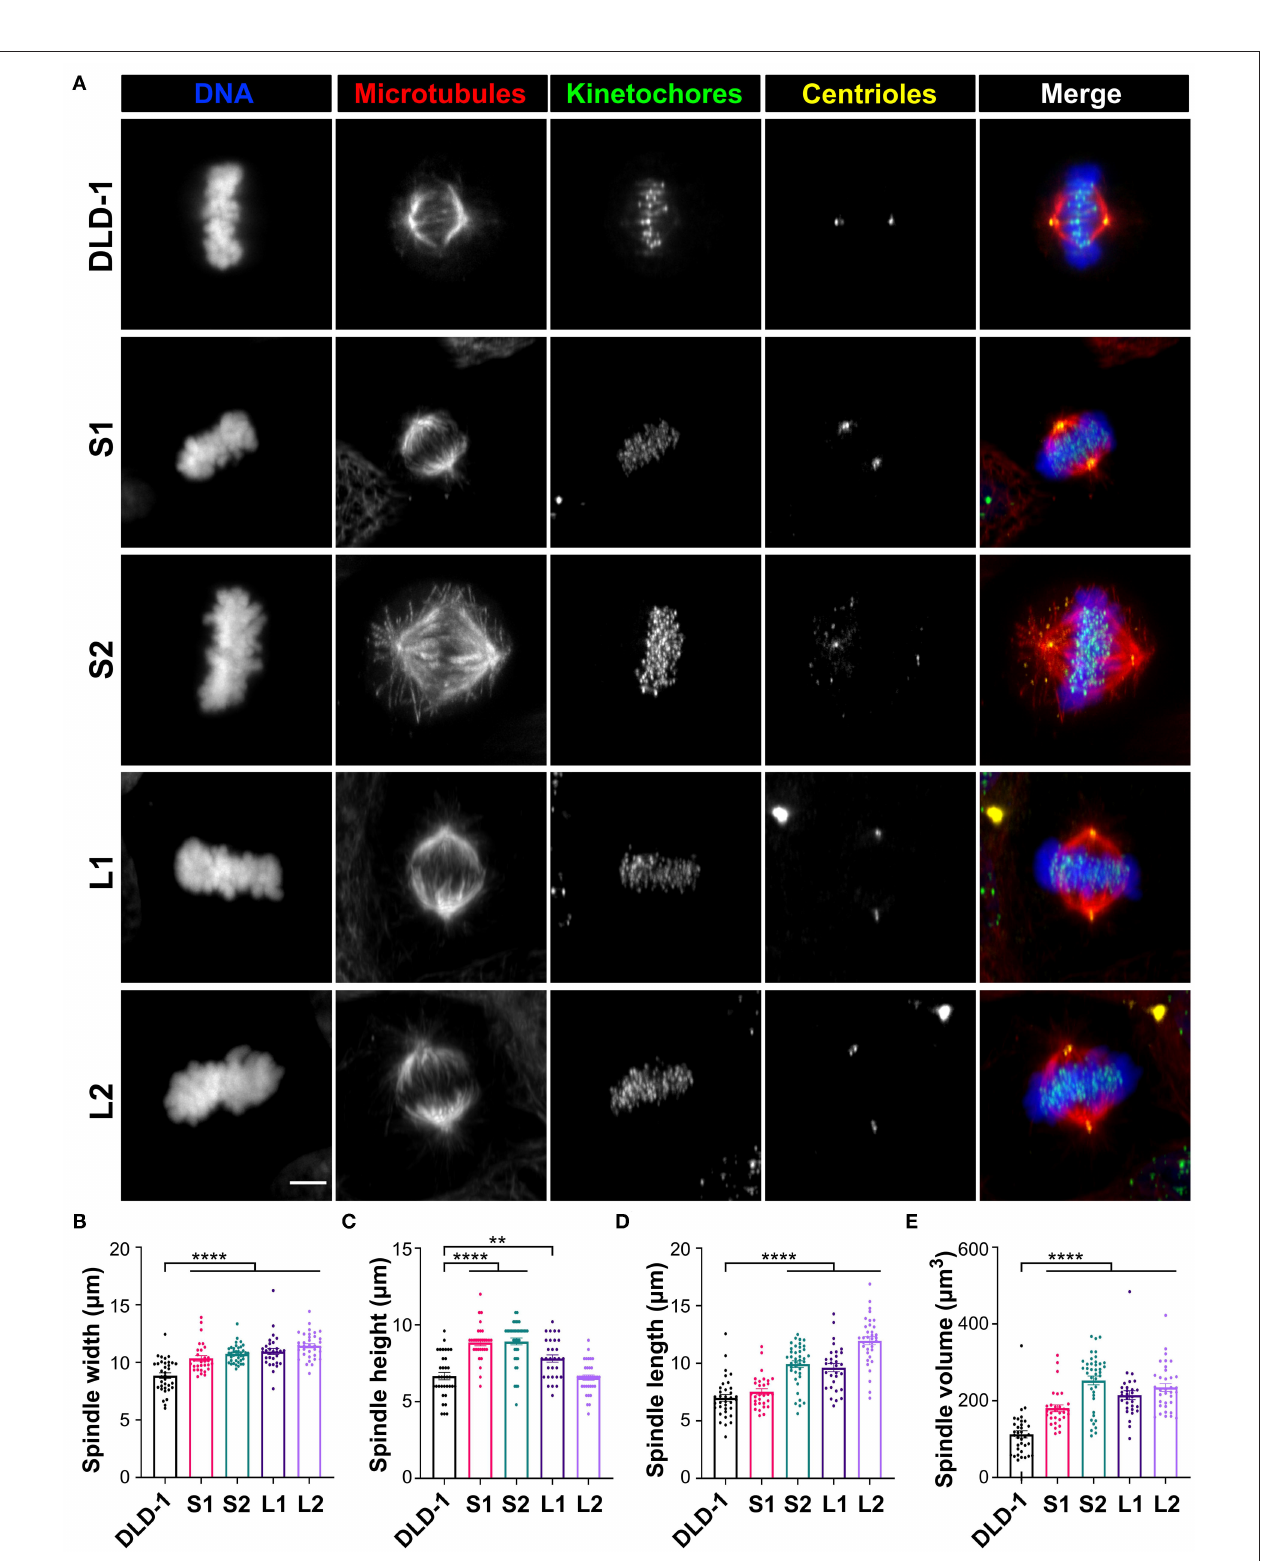
FIGURE 2 | Tetraploid DLD-1 clones have distinct mitotic spindle geometries. (A) Examples of mitotic spindles from parental DLD-1 cells and cells from 4N DLD-1 clones S1, S2, L1, and L2 (top-to-bottom) in metaphase. Scale bar, 5 µ m. Measurements of mitotic spindle width (B) , height (C) , length (D) , and volume (E) reported as mean SEM with individual data points from three independent experiments in which a total of 30–40 cells ( n ± **** p < 0.0001, when compared to the parental DLD-1 cells by Student’s t -test.